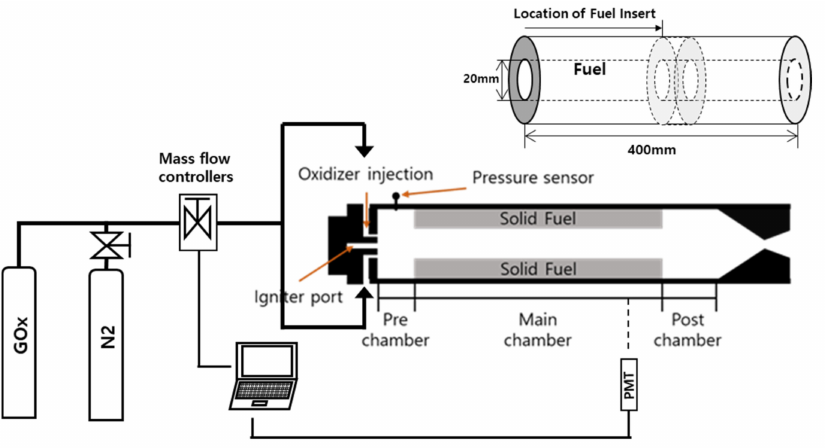
Figure 3. Schematic of test configuration and PMT setup for image